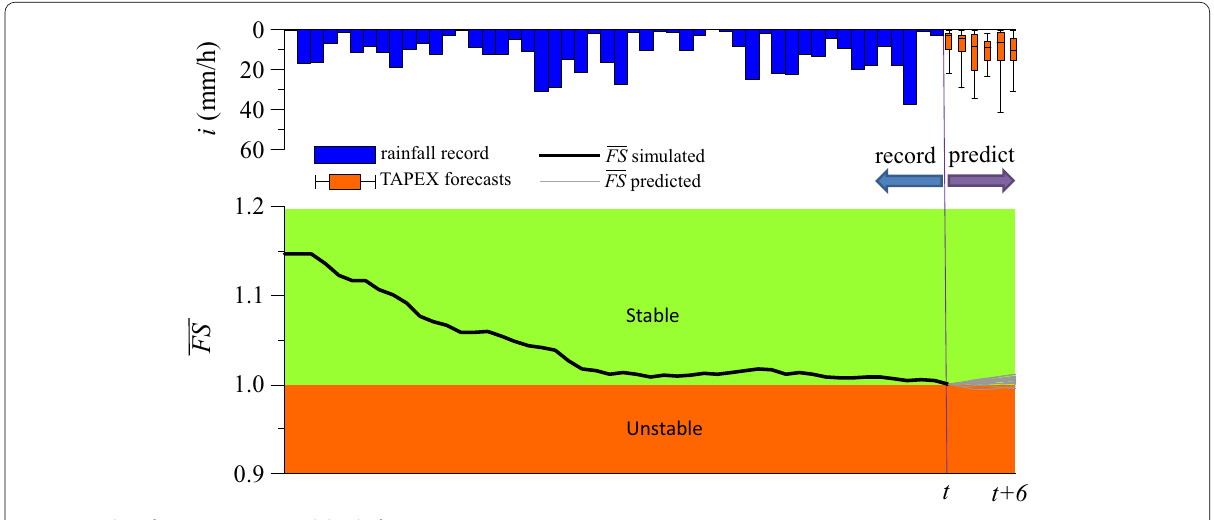
Fig. 1 Display of TAPEX‑SIMTOP model’s